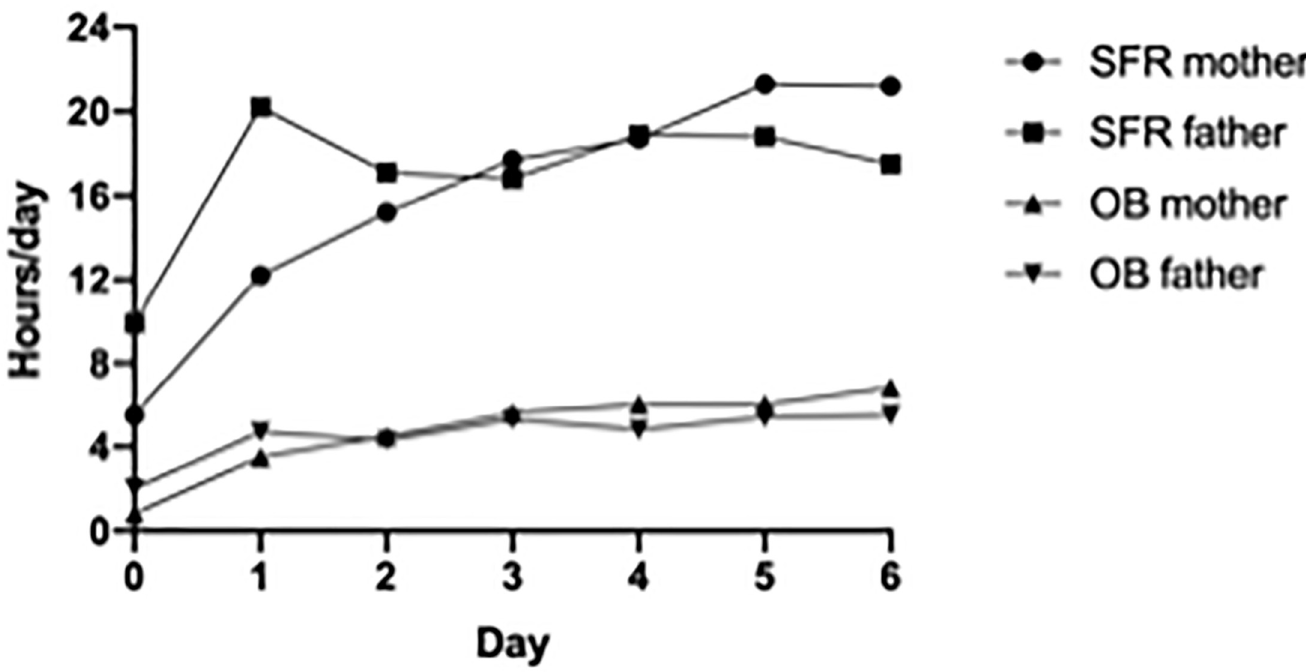
Fig 2. Parental presence first week. Mean hours of daily presence during first week of hospitalisation by mothers and fathers in the SFR unit and OB unit.